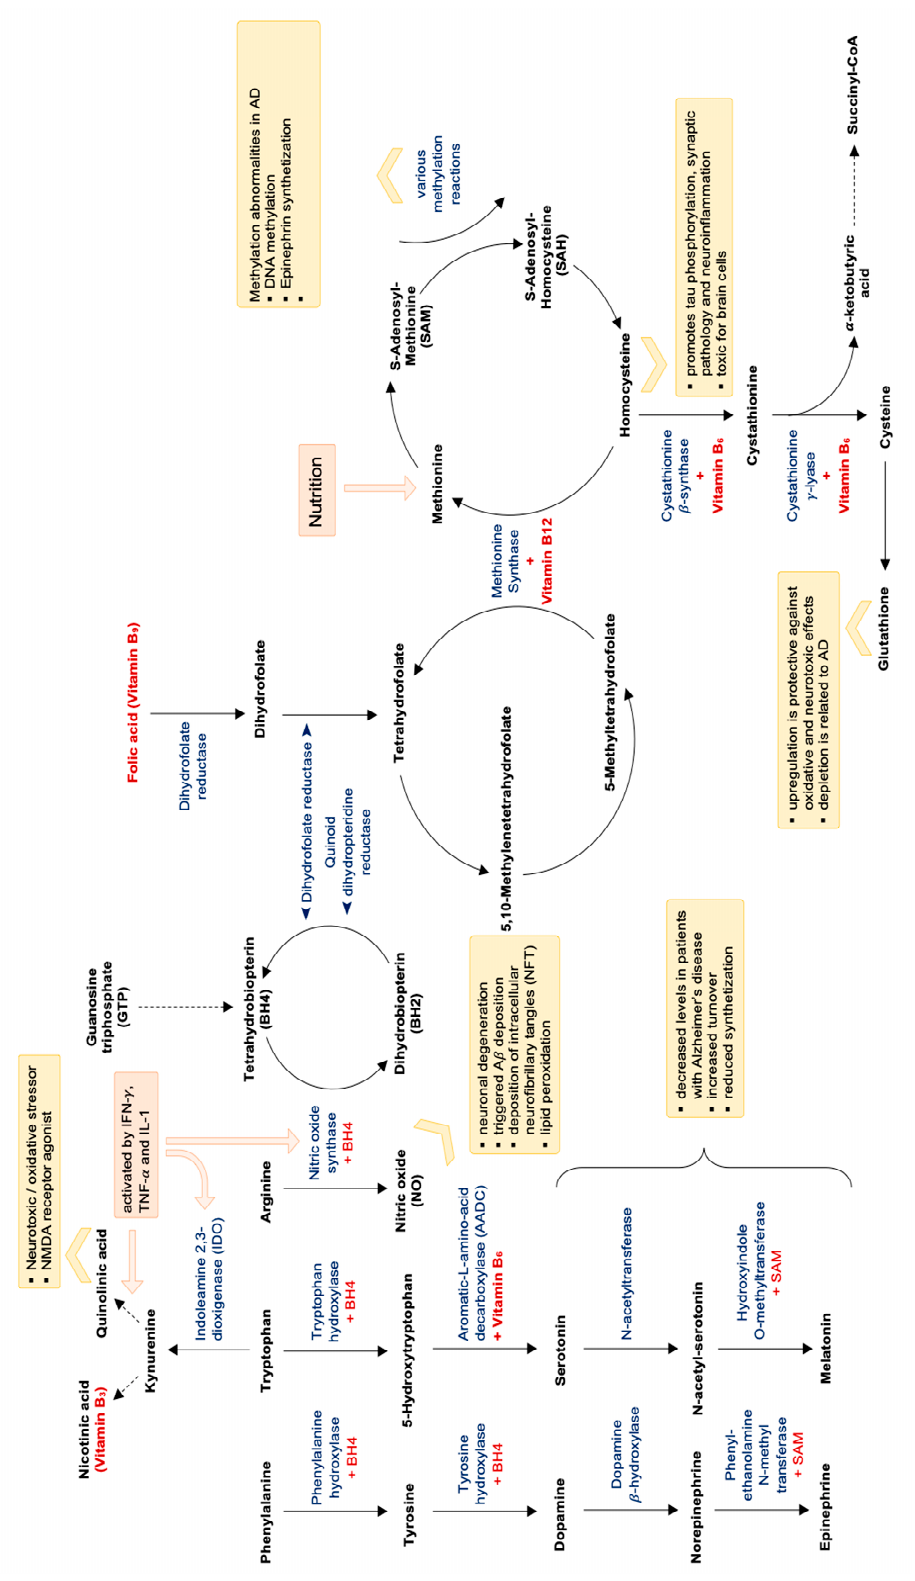
Figure 3. Methylation cycle, folate cycle, oxidative stress and neurotransmitter synthetization and dependent on vitamin B levels. Abbreviations: NMDA = N ‐ methyl ‐ D ‐ aspartate; AD = Alzheimer’s disease; SAM = S ‐ Adenosyl ‐ Methionine; BH4 = Tetrahydrobiopterin; CoA = coenzyme A.